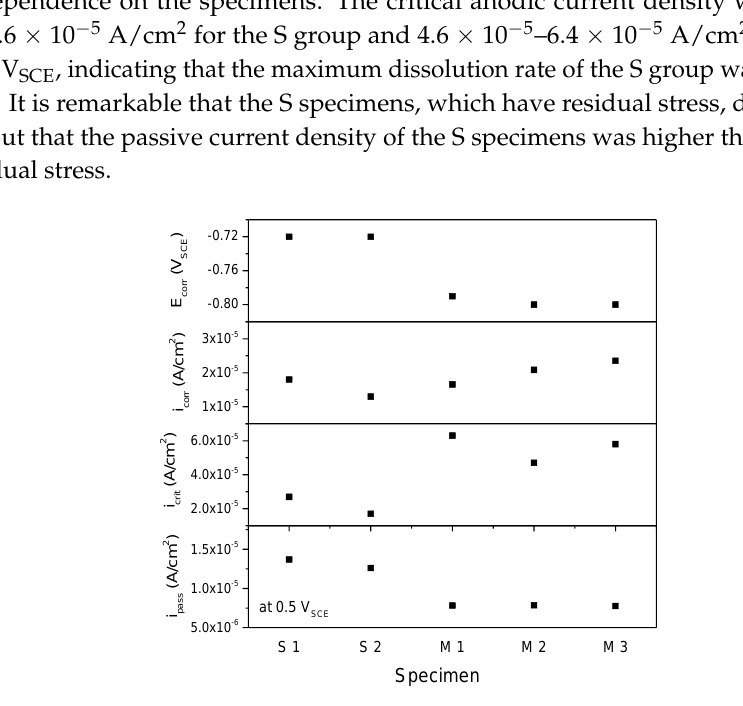
Figure 6. Corrosion parameters determined from the potentiodynamic polarization curves.